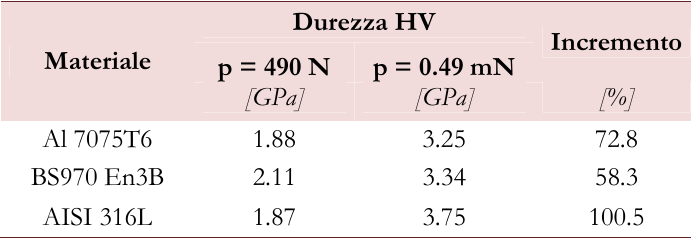
Table 2: Comparison between measured micro- and macro-